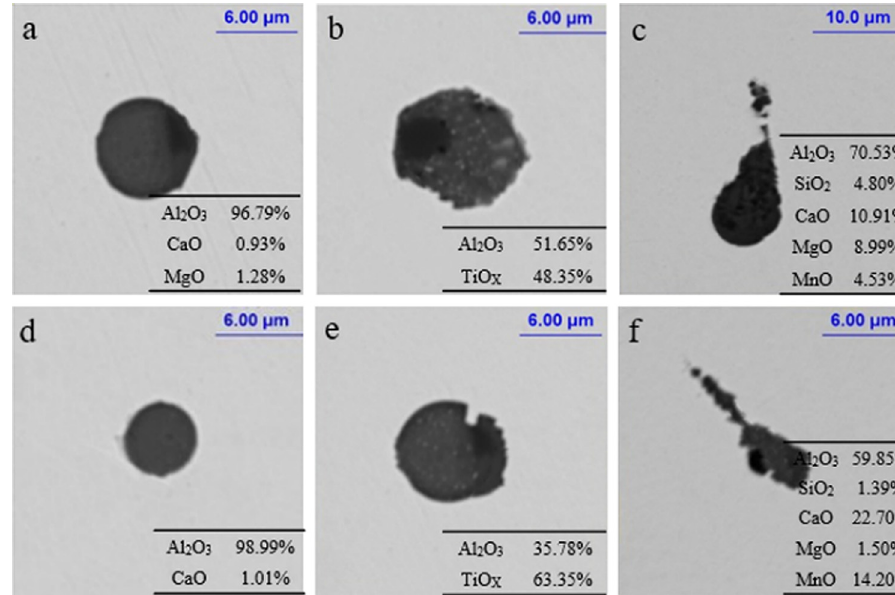
Figure 3: The morphology and compositions of typical inclusions: ( a – c ) with original modi fi er and ( d – f ) with new modi fi er.